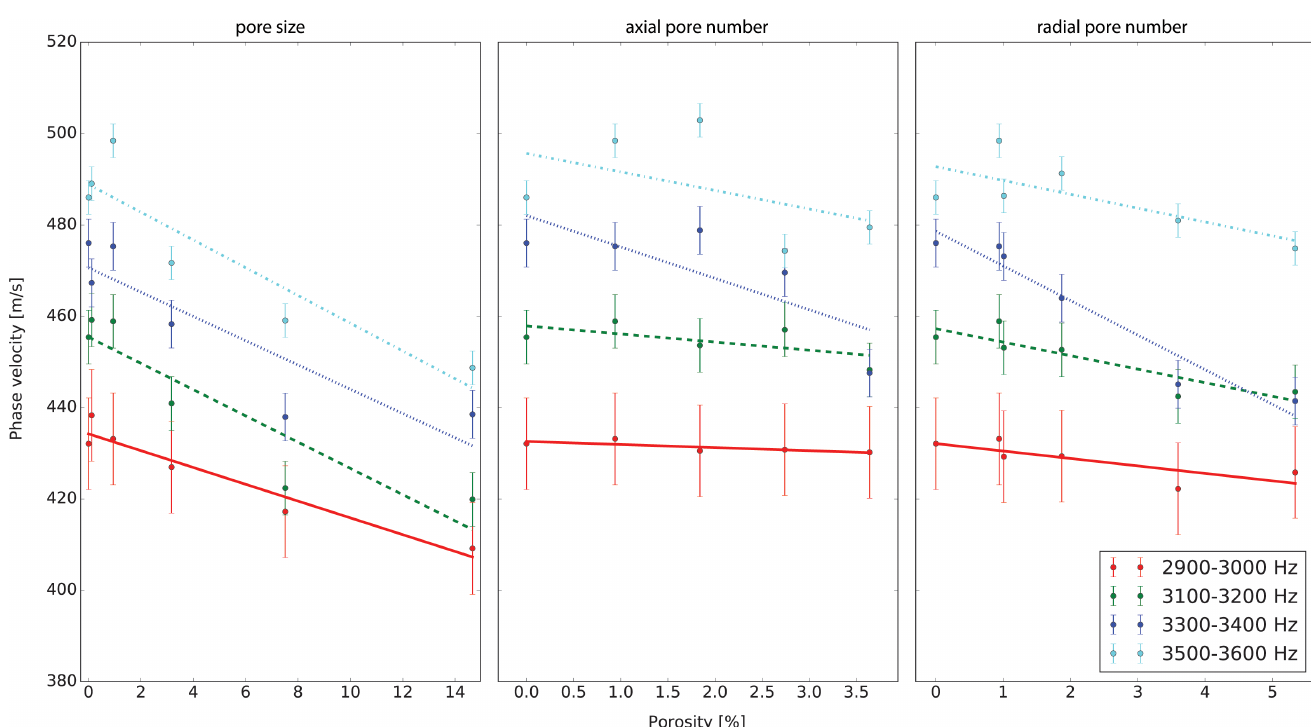
Fig 3. Phase velocity as a function of porosity (pore volume fraction), caused by an increasein pore size (left), radial pore number (middle), or axial pore number (right). Note the varyingabscissae.